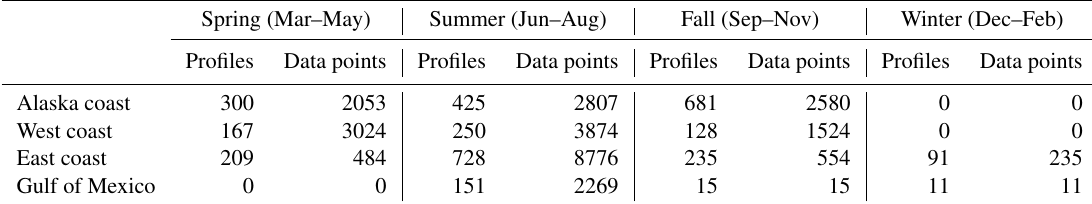
Table 6. Number of profiles and data points (the sum of all depth levels at each profile) in all seasons of each region.